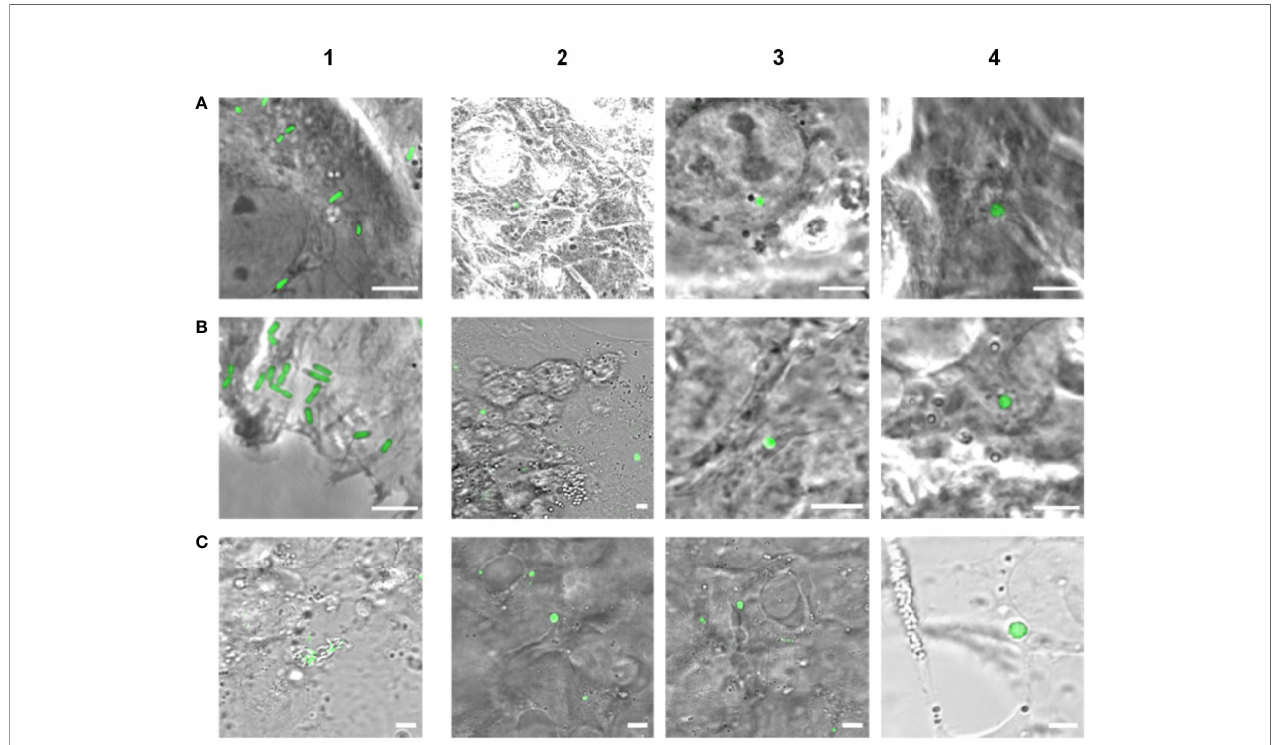
FIGURE 3 | Evidenceof intracellular formation of L-formsafter Ampicillin treatment (200 µg/ml) of eukaryotic celllines infected with GFP-labeled Listeria monocytogenes . Images incolumn 1 show infected cells prior to antibiotictreatment, whereas columns 2 - 4 display Ampicillin treatedcellcultures. (A) Micrographs of HBME cellsinfected with L.monocytogenes EGDe Rev10 before treatment (1),2 days(2),4 days (3)and 12 days (4) after Ampicillin treatment. (B) Micrographs of BeWo cells infected with L. monocytogenes EGDeRev10 before treatment (1), and4 days (2-4) after Ampicillin treatment. (C) Micrographs ofHBME cells infectedwith L. monocytogenes WSLC1042 Rev30 before treatment (1),6 days(2), and14 days(3-4)after Ampicillin treatment. Scalebar = 5